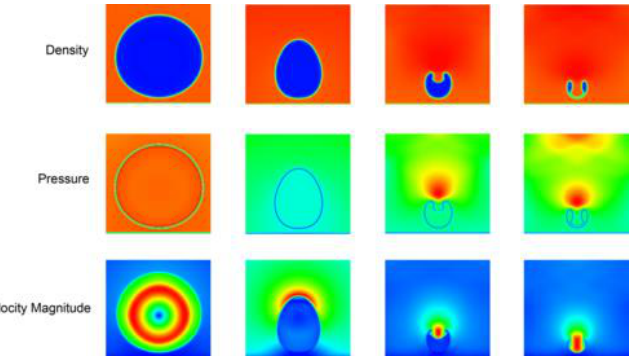
Figure 5. Sequences of collapse process of a H 2 O vapour bubble near a solid wall (from left to right), shown by density, pressure, and velocity magnitude fields (reproduced with permission from Ref. [82], Copyright 2020, American Physical